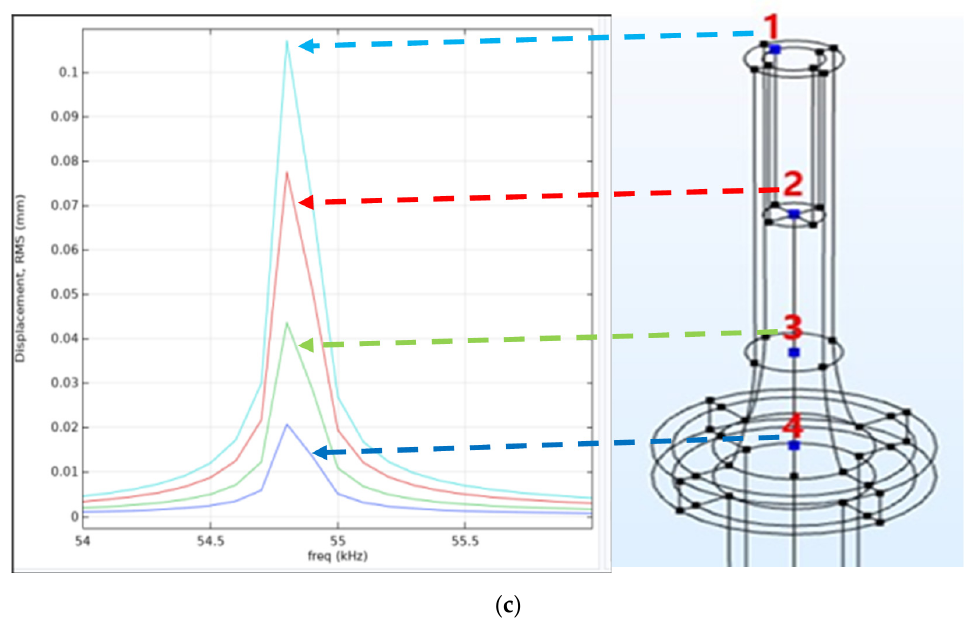
Figure 2. ( a ) Optimizer design setup, ( b ) modal analysis result, and ( c ) harmonic analysis result for the UT.